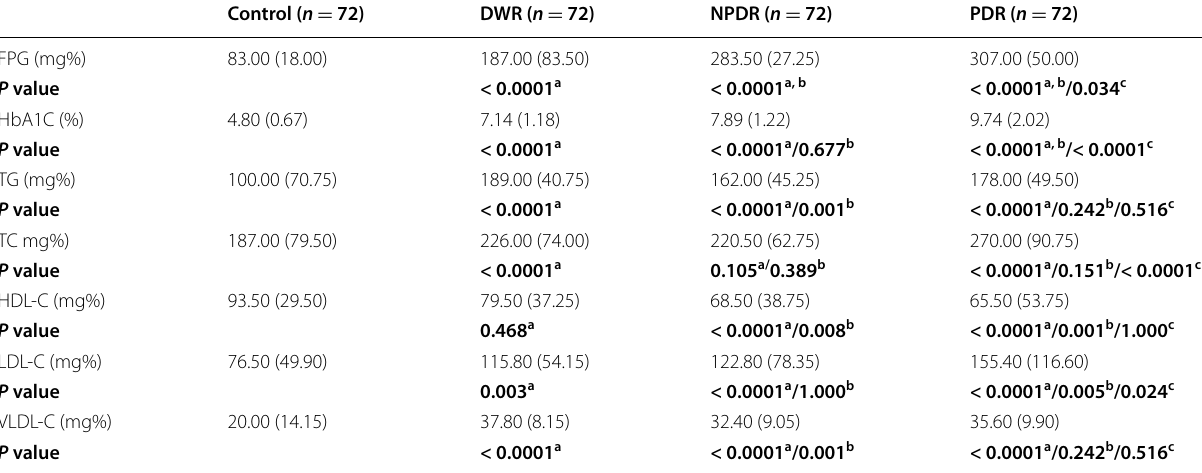
Data are expressed as median (interquartile